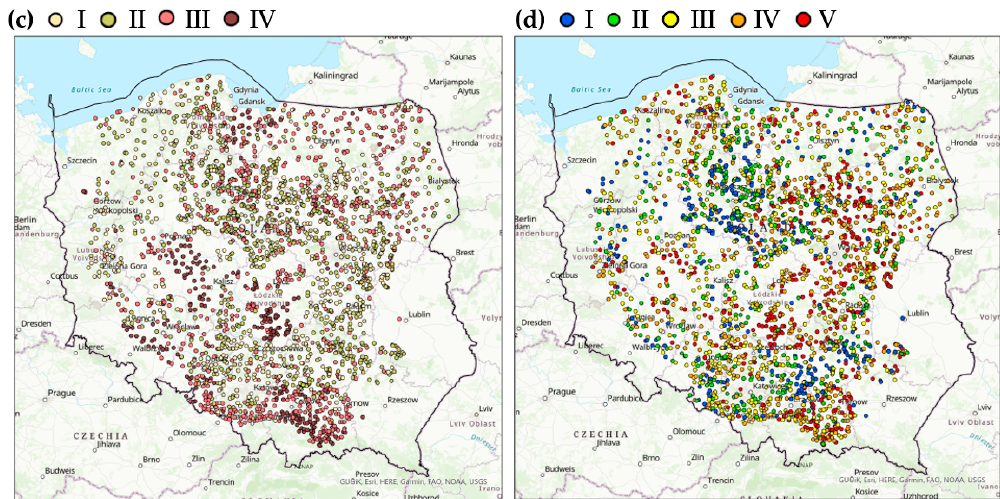
Figure 2. The soil characteristic distribution among the sites ( a ) organic carbon: I—<1% C (very low),